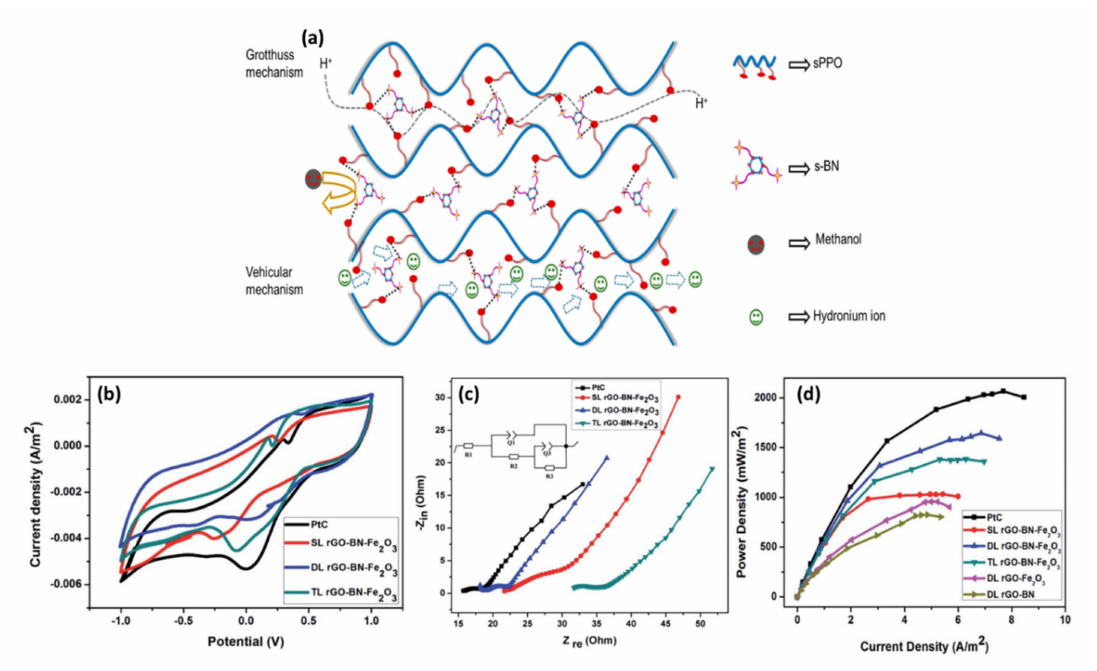
Figure 10. ( a ) Schematic representation of composite membranes illustrating the methanol crossover resistance (by sBN) and improved proton conductivity by adding sulfonic acid groups of sBN by hopping and vehicular mechanism [153] (Reprinted with permission from American Chemical Society, Copyright © 2020). ( b ) cyclic voltammetry and limiting current (derived from cyclic